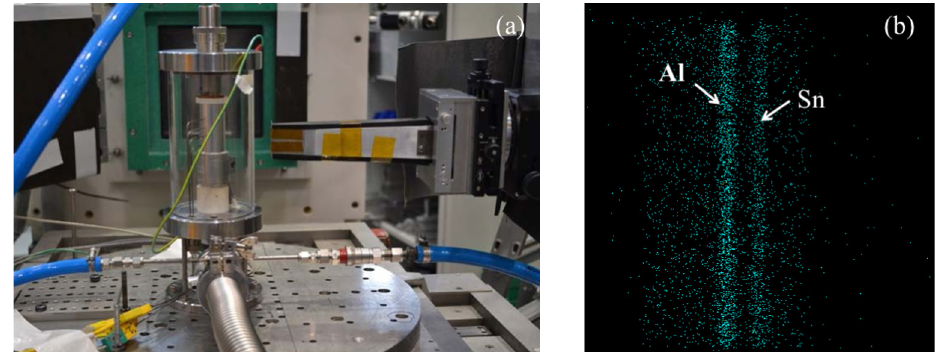
Fig. 3. (a) Specimen chamber mounted on KOWARI diffractometer and (b) diffraction pattern as observed on detector.